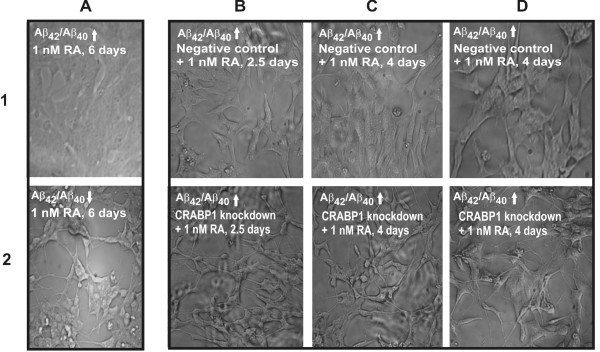
Increased Aβ42/Aβ40 ratio reduced responsiveness of SH-SY5Y cells to RA and the knock down of up-regulated CRABP1 rescued their differentiation potential. Phase contrast images showing living human neuroblastoma cells (SH-SY5Y), grown on collagen coated glass cover slips and treated with 1 nM retinoic acid (RA). Differentiation was evaluated by the number, shape and length of outgrowing protrusions: (1A) C99I45F (Aβ42/Aβ40↑); (2A) C99V50F (Aβ42/Aβ40↓). Differentiation was evaluated after RA-treatment for 6 days. Both cultures were 50% confluent when RA was added (day zero). C99I45F reached 90–100% confluency after 4–6 days without any signs of differentiation, whereas C99V50F did not exceed more than 60–70% confluency (after 6–10 days) but showed strong differentiation. C99I45F was also evaluated at 60–70% of confluency showing no signs of differentiation (data not shown), thus strong confluency of C99I45F (shown here) does not conceal putative signs of differentiation. (B) C99I45F (Aβ42/Aβ40↑): 30 nM siRNA was administered to the cells for 24 hours in combination with a treatment of 1 nM RA for 2.5 days. After 2.5 days, the effects of more than 50% knockdown of CRABP1 (2B) was compared with a nonsense sequence (negative control, (1B)). (C) C99I45F: same conditions as in (B) except that RA was administered for 4 days. Differentiation was evaluated after 4 days. Knockdown of CRABP1 (2C) was compared with a nonsense sequence (negative control, (1C)). (D) C99I45F: same conditions as in (C), but with another preparation from the same experiment as in (C). (B) and (C) show preparations from different experiments. Experiments were repeated three times with consistent results.